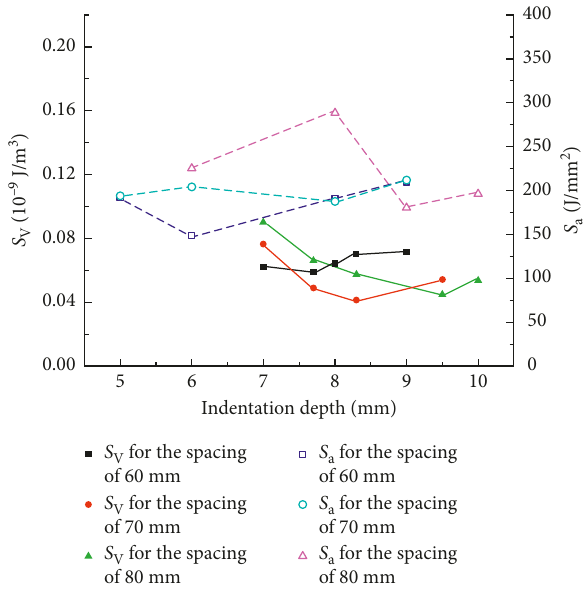
Figure 13: Indentation efficiency in numerical and laboratory